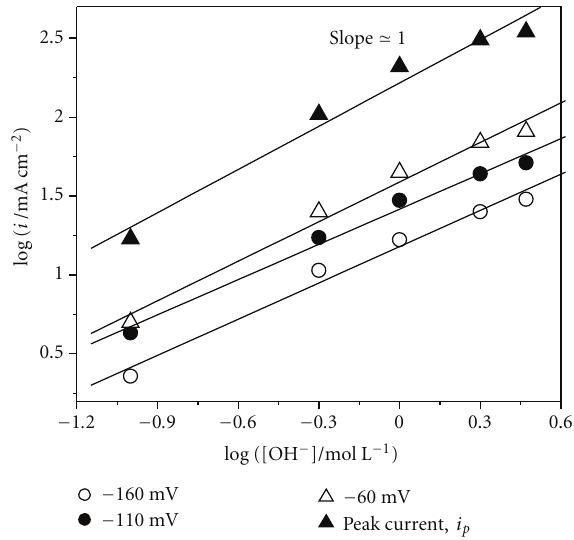
Figure 10: Dependence of methanol oxidation rate on NaOH con- centration in 1.0 M methanol with various NaOH concentrations on Pt-Pd/C catalyst at di ff erent